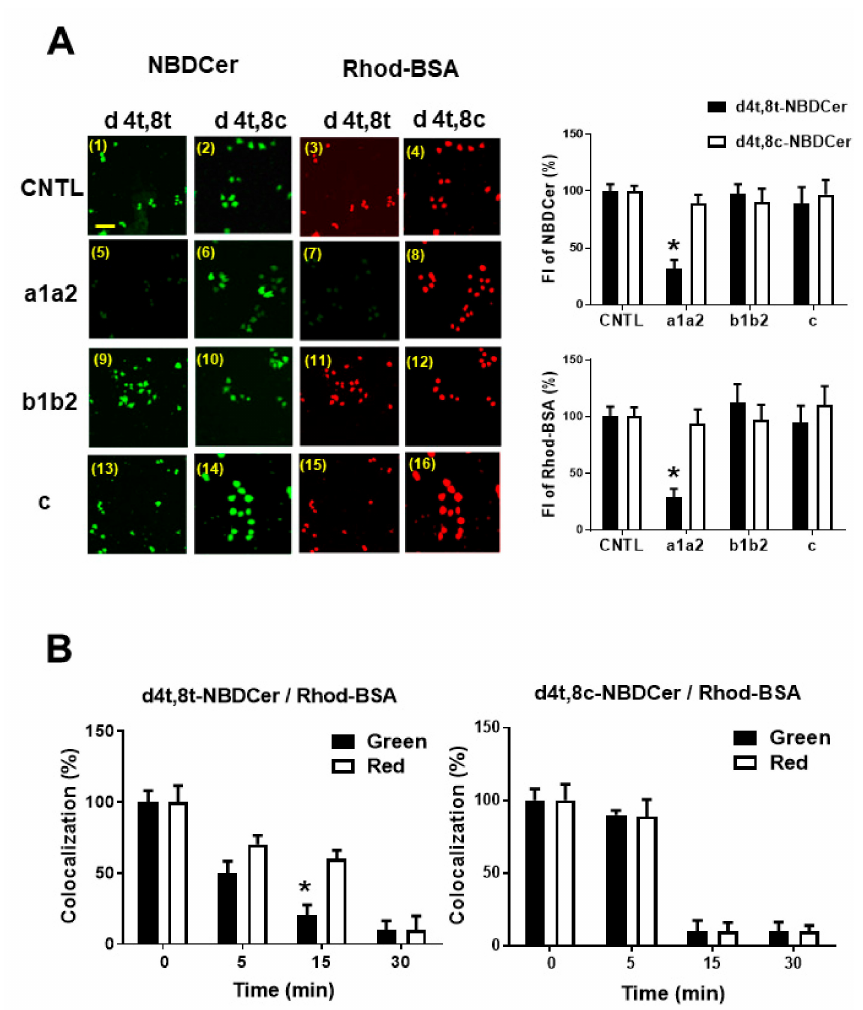
Figure 6. Inhibition profile of the Nrp1 domain of NBD-Cer and Rhod-BSA binding to PC12 cells. ( A ) Representative images of Plex A1 gene-silencing PC12 cells examined together with Nrp1 domains a1a2, bib2, and c (100 nM), or control (CNTL) plus 100 nM NBD-Cer / 100 nM Rhod-BSA. Scale bar = 100 µ m. Changes in FI are shown in the right upper graph (NBD-Cer) and lower right graph (Rhod-BSA). Data are presented as mean ± SD ( n = 3; * p < 0.01). ( B ) Colocalization of d4t,8t- or d4t,8c-NBD-Cer and Rhod-BSA during dissociation (0 to 15 min) in cells. Green ( (cid:4) ) indicates occupation based on NBD fluorescence, and Red ( (cid:3) ) indicates occupation based on Rhod fluorescence. Data are expressed as FI (%) at 0 min and are presented as mean ± SD ( n = 3; * p <